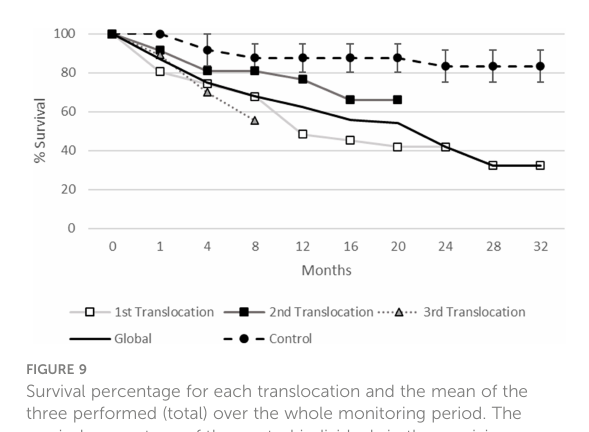
FIGURE 9 Survival percentage for each translocation and the mean of the three performed (total) over the whole monitoring period. The survival percentage of the control individuals in the receiving population located in La L ı ́ nea port is also shown for comparison. Three 10 m transects were monitored and the mean ± standard error of their survival values is shown for the control